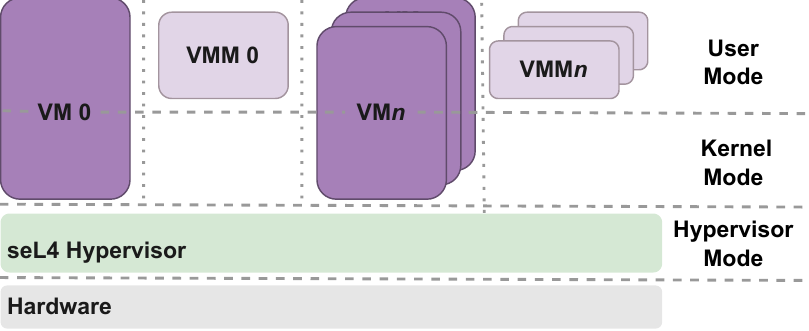
Figure 2. Example of an architecture with one VMM per